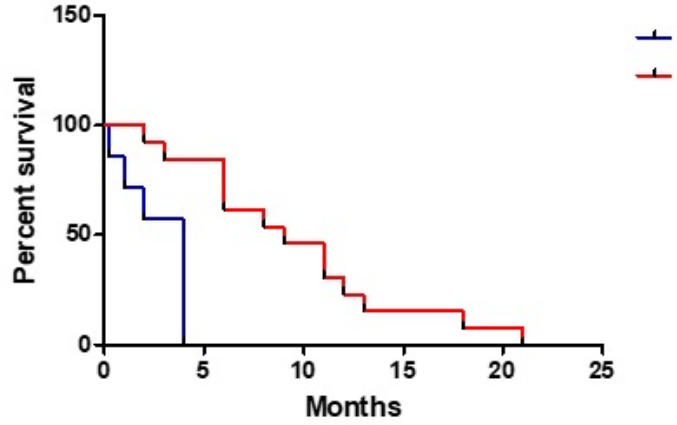
Figure 2. Role of postoperative KPS on overall survival.